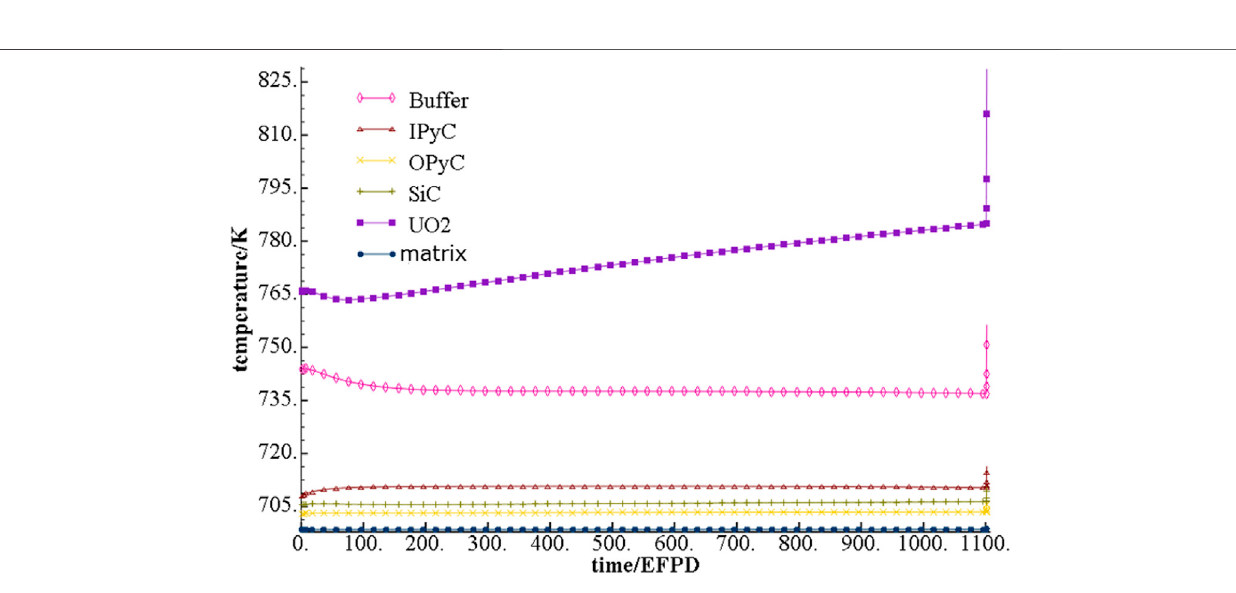
Frontiers in Energy Research |